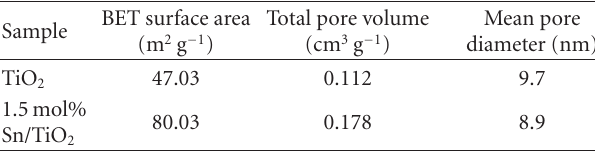
Table 3: BET data for TiO 2 and 1.5 mol% Sn/TiO 2 .